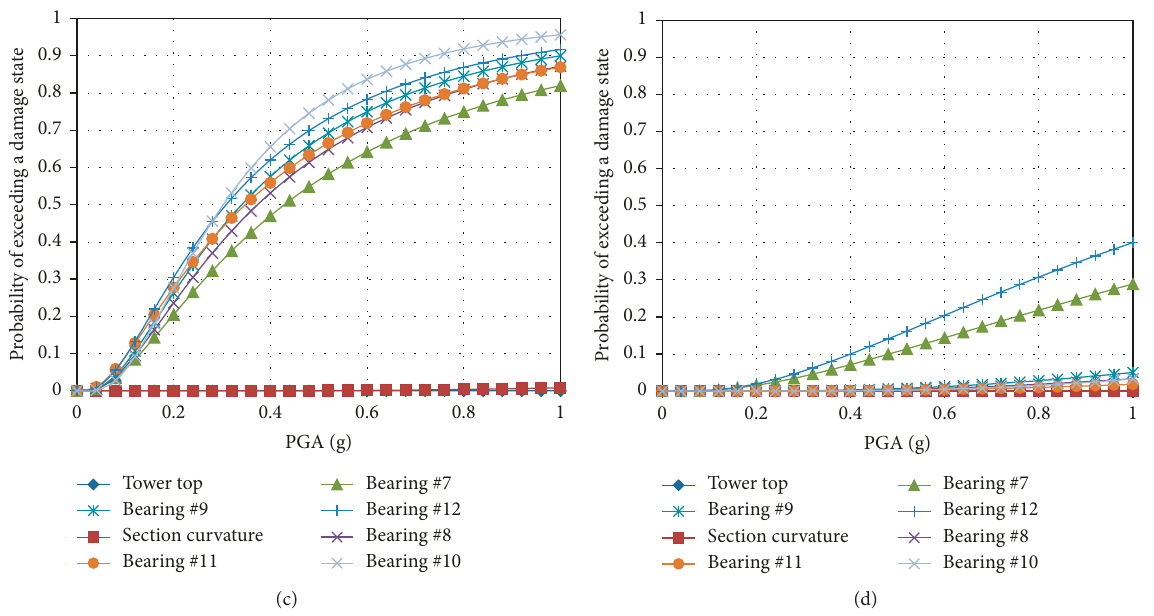
Figure 16: Longitudinal fragility curves of components. (a) Slight damage. (b) Moderate damage. (c) Extensive damage. (d) Complete